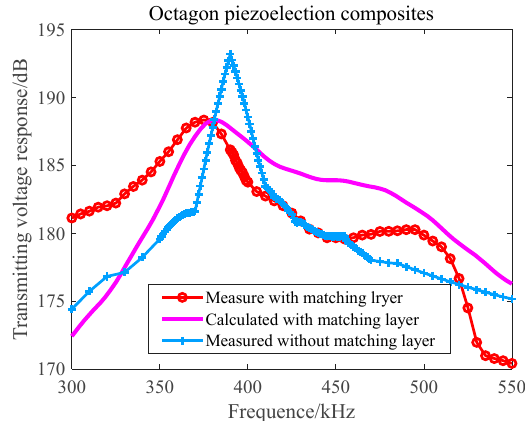
Figure 16. Transmitting Voltage Response–Frequency Curve of an Octagonal Transmitting Array.